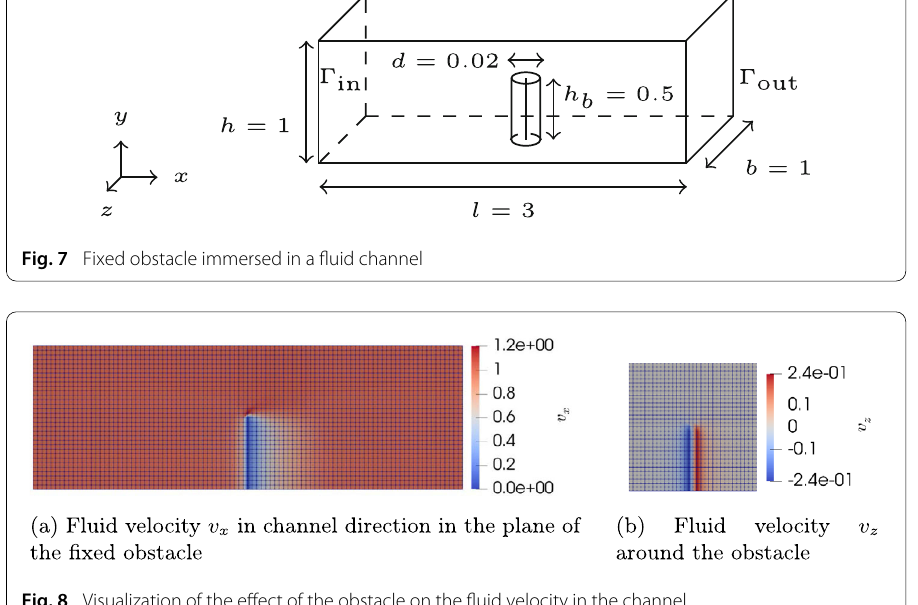
all other surfaces. The fixed beam obstacle is placed in the middle of the lower channel surface and is assumed to not be affected by the surrounding fluid. This allows to consider only one-way coupling from the fixed beam onto the fluid. The fluid is assumed to have a density of ρ = 1 and a dynamic viscosity of μ = 0 . 004. The fluid domain is discretized by 96 × 32 × 32 stabilized 8-noded hexahedral finite elements with equal-order interpolation, 1 2, with time step size (cid:13) t = 10 − 3 . Note that for the proposed method with θ =